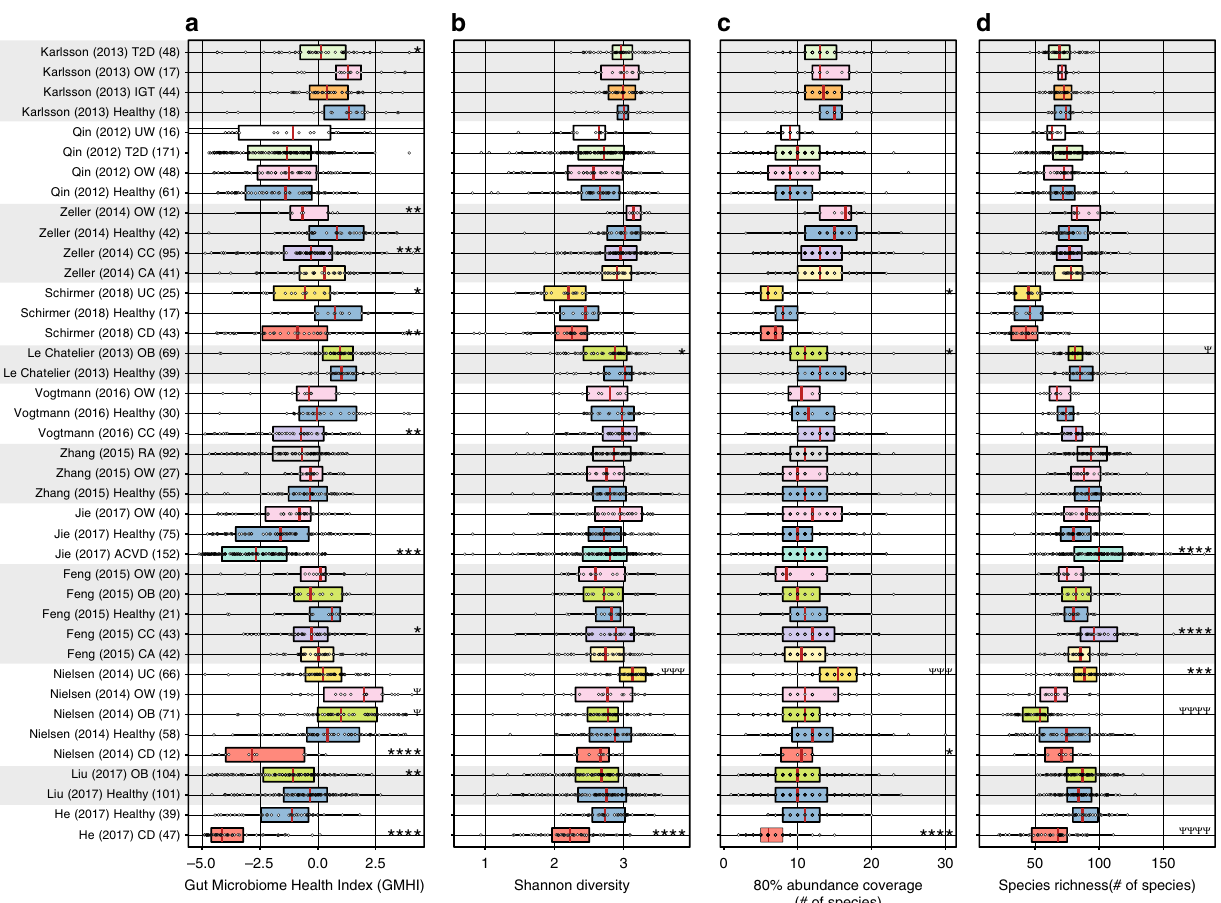
Fig. 5 GMHI generally outperforms other microbiome ecological characteristics in distinguishing case and control across multiple study-speci fi c comparisons. In each of the 12 studies wherein at least 10 case (i.e., disease or abnormal bodyweight conditions) and at least 10 control (i.e., healthy) subjects were available, stool metagenomes were analyzed to compare a GMHI, b Shannon diversity, c 80% abundance coverage, and d species richness between healthy and nonhealthy phenotype(s). GMHI was found to have a signi fi cantly higher distribution in healthy for 11 (out of 28) case – control comparisons across nine different studies; Shannon diversity and 80% abundance coverage were found to have signi fi cantly higher distributions in healthy for two and four case – control comparisons (across two and four studies), respectively; and species richness was found to have a signi fi cantly lower distributions in healthy for three case – control comparisons across three different studies. Each study ’ s phenotype sample size is shown within parentheses to the right of the phenotype abbreviation. Standard box-and-whisker plots (e.g., center line, median; box limits, upper and lower quartiles; whiskers, 1.5× interquartile range; points, samples) are used to depict groups of numerical data. The same colors in boxplots were used for the same phenotypes. P values (two-sided Mann – Whitney U test) for each study-speci fi c comparison between healthy and nonhealthy phenotypes are shown adjacent to the boxplots accordingly: * and Ψ indicates signi fi cantly different distributions consistent with, and opposite to, respectively, the previously observed results when healthy and nonhealthy groups were compared in aggregate. * or Ψ 0.01 ≤ P value<0.05; ** or ΨΨ 0.001 ≤ P value<0.01; *** or ΨΨΨ 0.0001 ≤ P value<0.001; **** or ΨΨΨΨ P value<0.0001. ACVD atherosclerotic cardiovascular disease, CA colorectal adenoma, CC colorectal cancer, CD Crohn ’ s disease, IGT impaired glucose tolerance, OB obesity, OW overweight, RA rheumatoid arthritis, SA symptomatic atherosclerosis, T2D type 2 diabetes, UC ulcerative colitis, UW